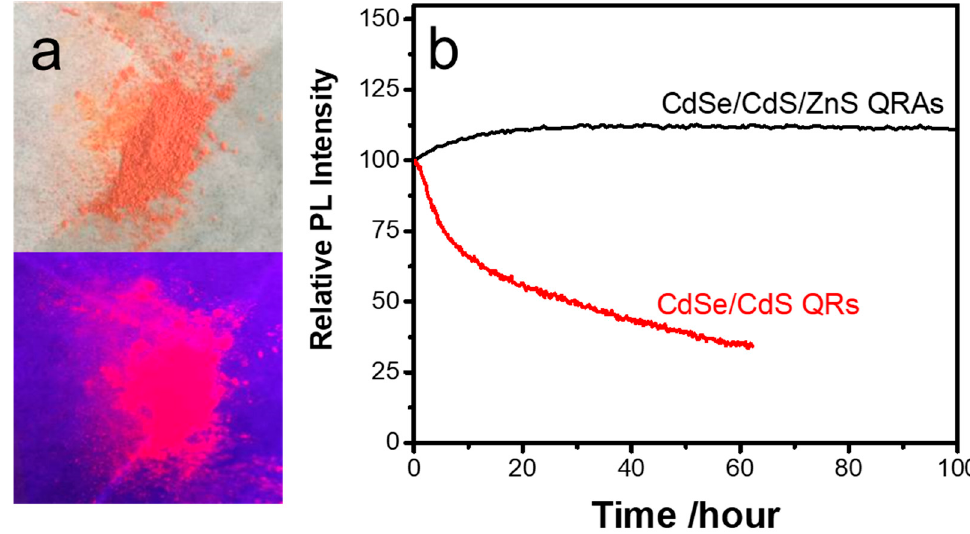
Figure 7. ( a ) QRAs powder under room light and UV irradiation; ( b ) long-term photostability of the CdSe/CdS and CdSe/CdS/ZnS QRAs under continuous excitation.